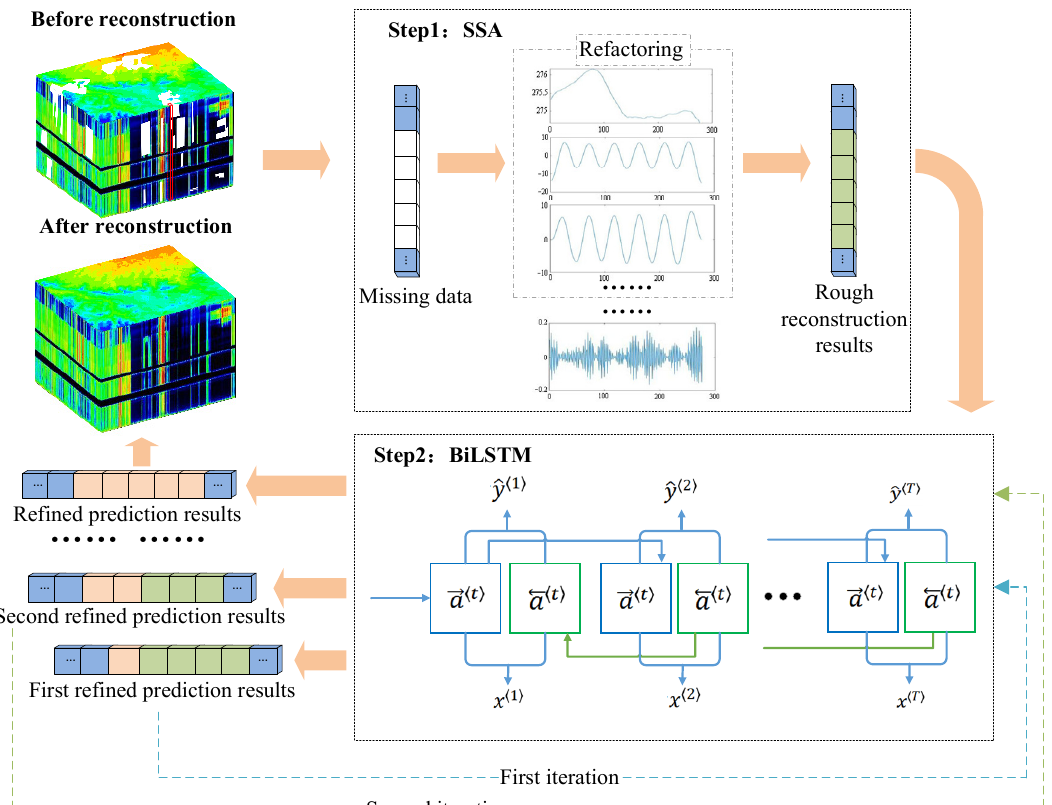
Figure 2. Process diagram of LST reconstruction based on the SSA-BiLSTM model.